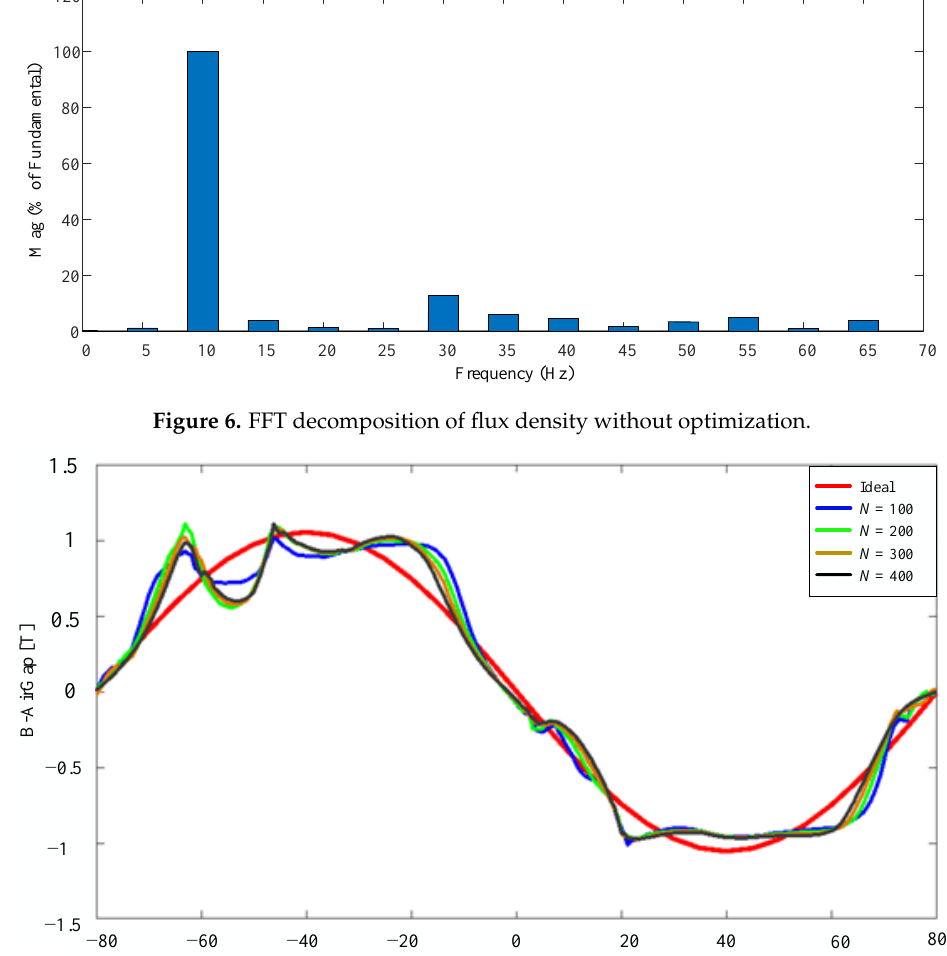
Figure 7. Flux density with level-set optimization. FFT analysis